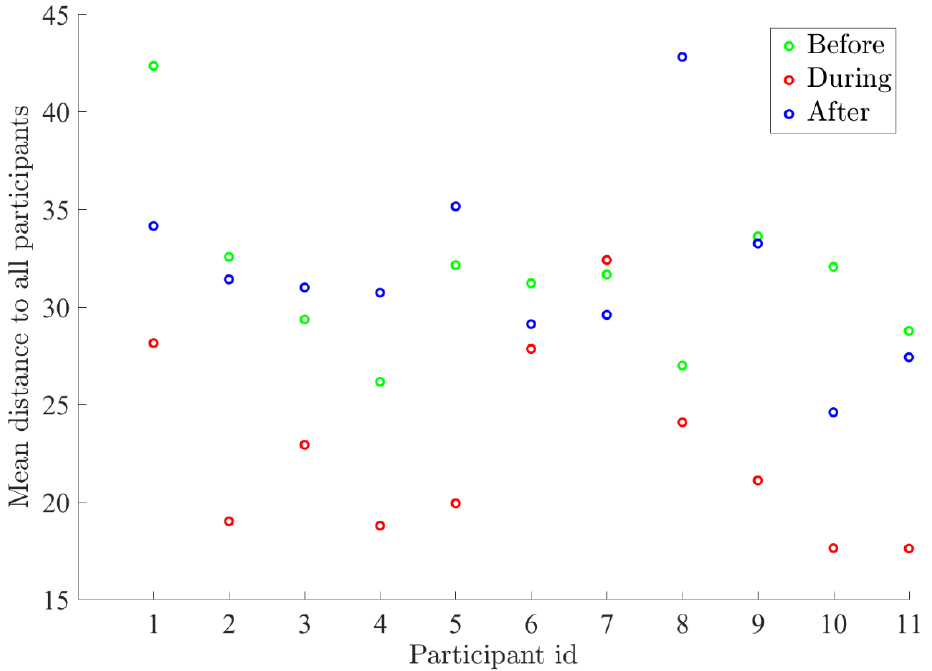
Figure A9. Pairwise synchronization for Saudi Arabia’s group. For the majority of participants (10 out of 11) the mean Euclidean distance during the HLI was smaller than before the HLI, indicating that the participants were more coherent with the group during the HLI than they were before it. The mean distance after the HLI is smaller than before the Heart Lock-In for 7 out of 11